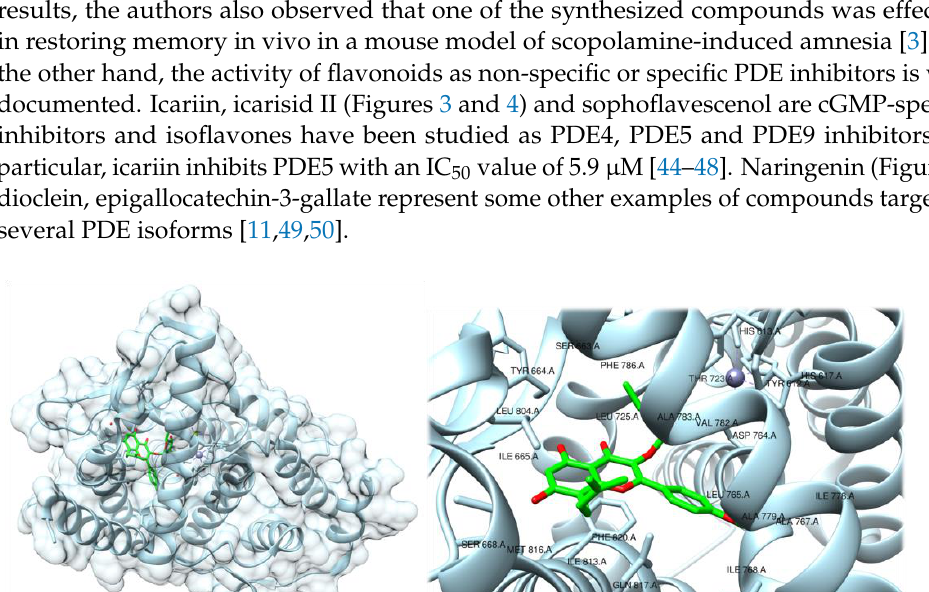
Figure 3. 3D structure of PDE5 in complex with icarisid II, a natural inhibitor from Epimedium brevicornium (PDB ID: 2H44). In the artwork, the residues interacting with the ligand (<5 Å ) have been labeled.